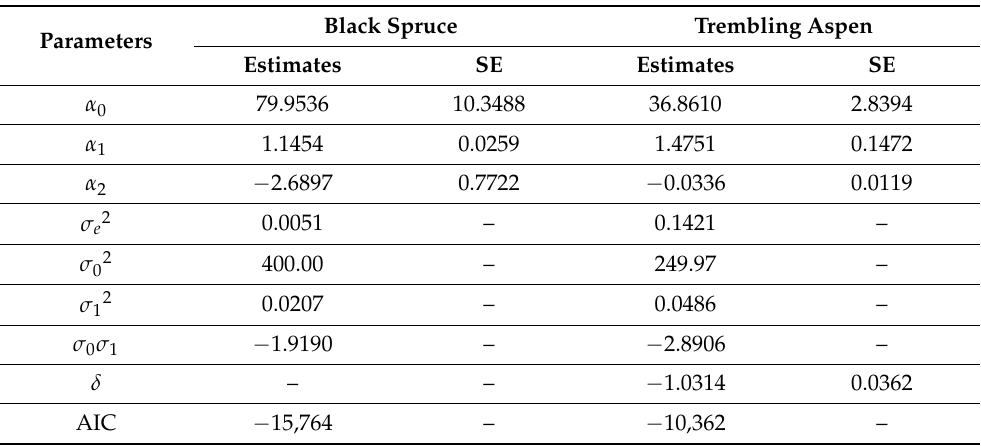
Table 3. Parameter estimates, standard errors (SE), fit statistics (MSE ( σ e 2 ), variance of b 0 ( σ 02 ), variance for black spruce (Equation (3)) and trembling aspen (Equation (4)) trees from Ontario,